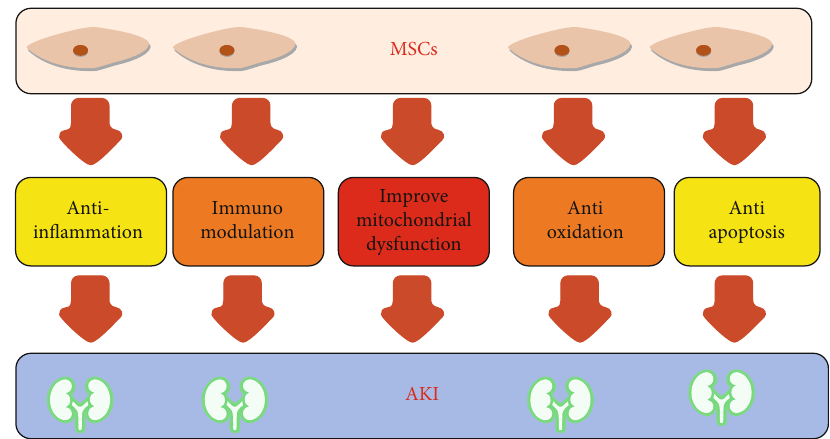
Figure 1: The mechanisms by which mesenchymal stem cells (MSCs) improve kidney